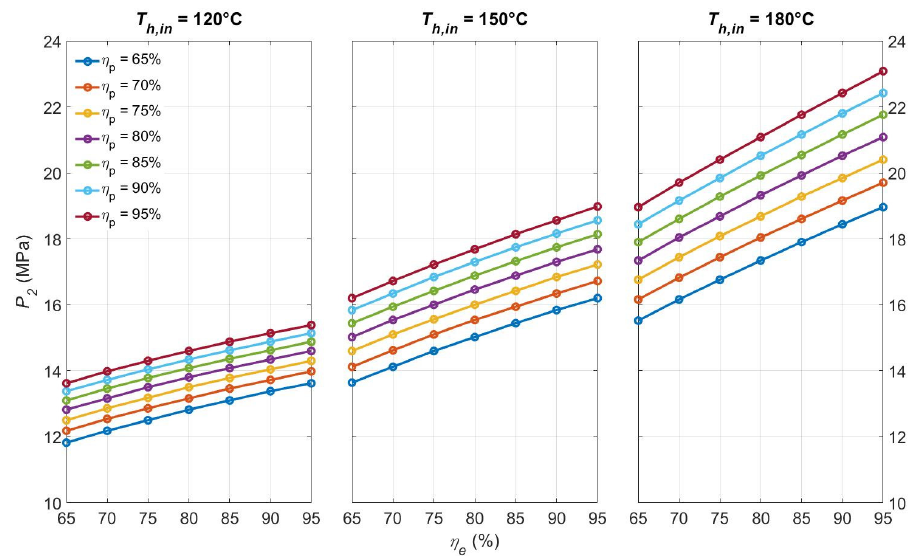
Figure 8. 𝑃 (cid:2870) of the simple cycle at the design point under different circumstances of 𝜂 (cid:3043) , 𝜂 (cid:3032) , and 𝑇 (cid:3035),(cid:3036)(cid:3041) .